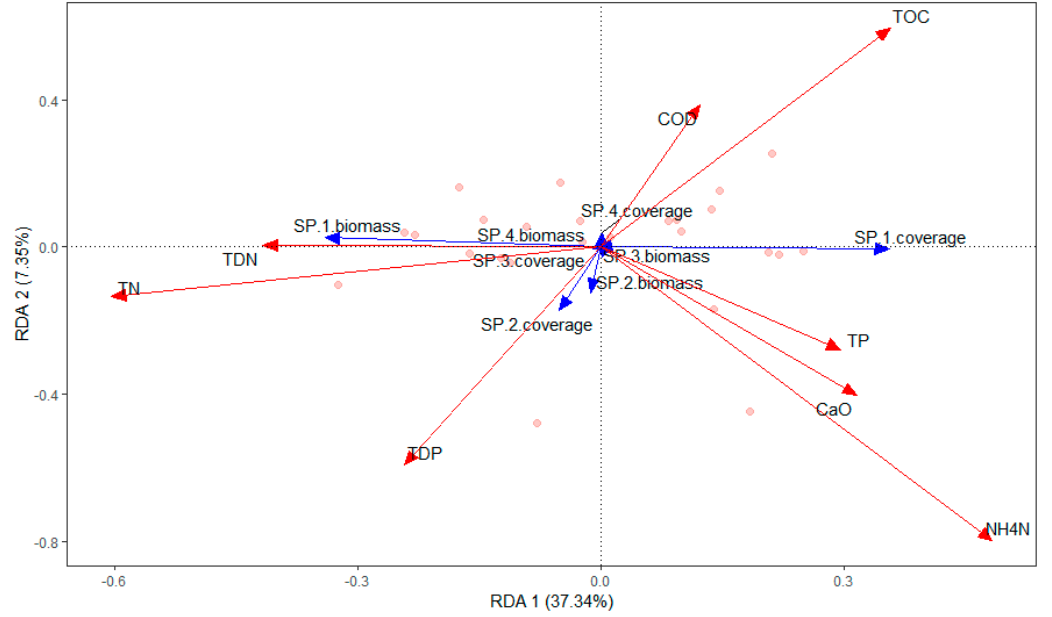
Figure 7. RDA ordination diagram of the relationship between aquatic species and nutrients in Chenghai Lake.